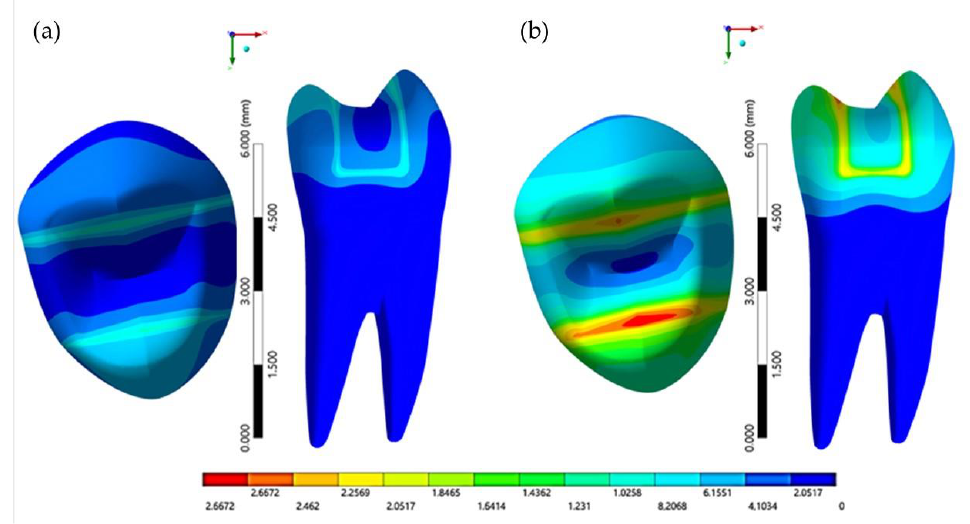
Figure 4. Cusp deflection as total deformation in ( a ) 100 μm cement thickness model and ( b ) 400 μm cement thickness. It is possible to see that the deflection cusp occurred with more intensity at the layer of highest thickness.